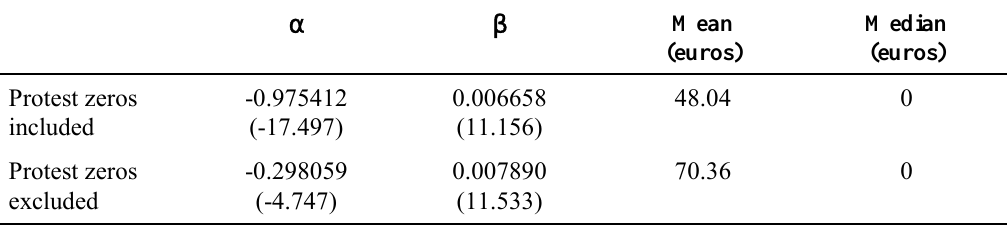
Table 1. Spike model estimation